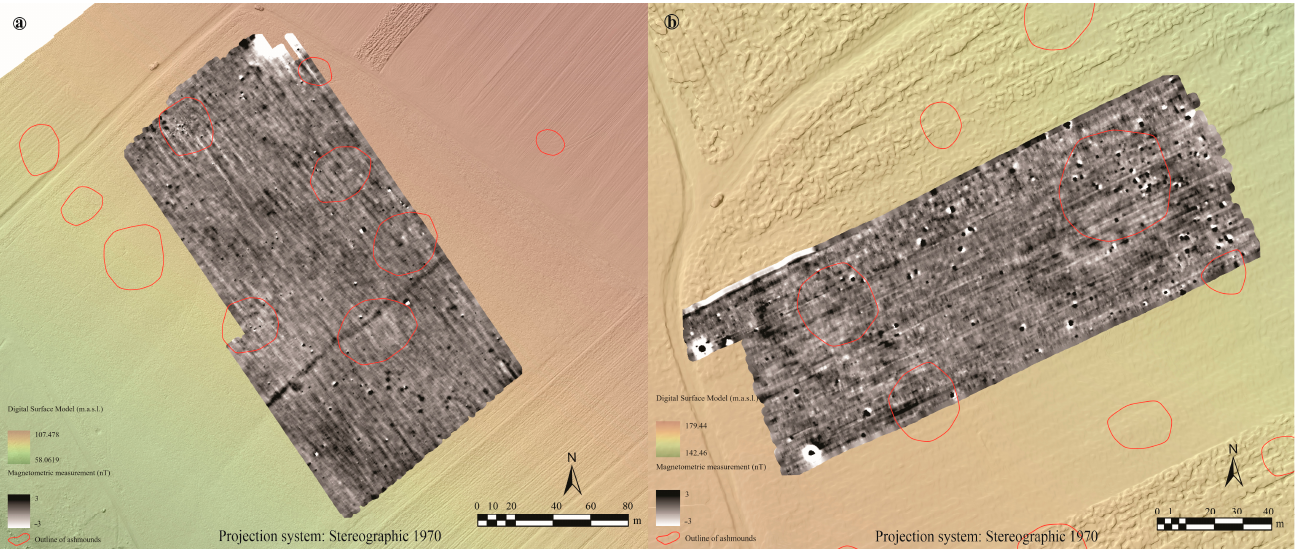
i County), north view. ,